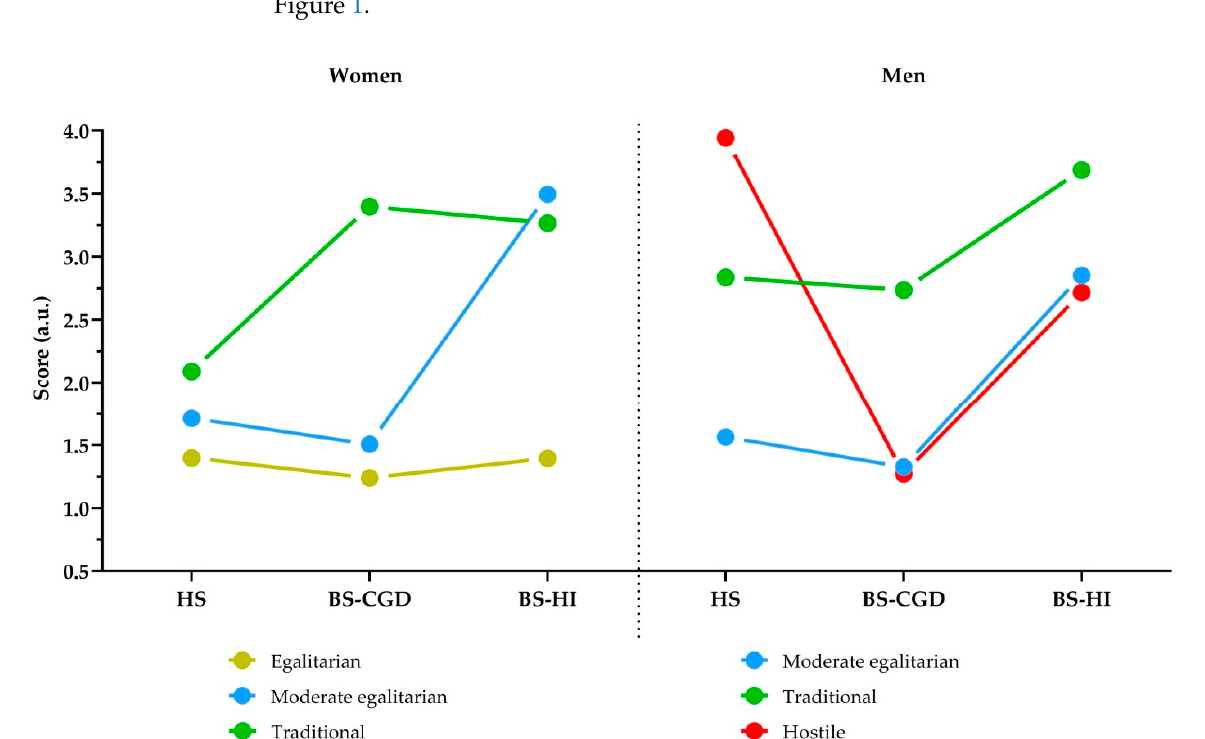
Table 9. Differences in women’s sexism endorsement types according to personal characteristics.